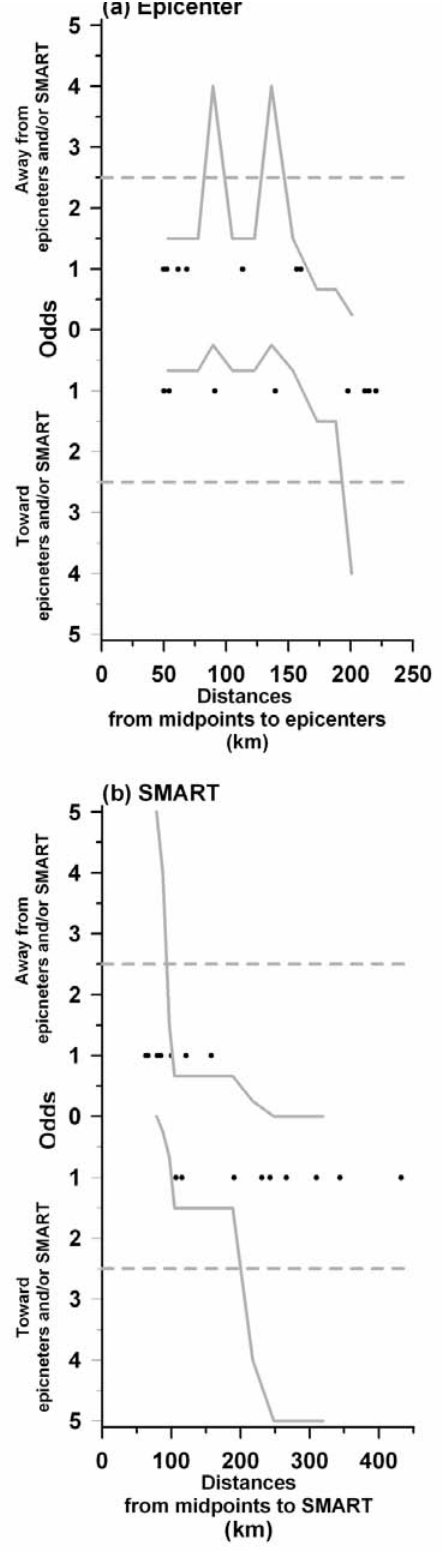
Figure 7. Relationships between the propagation azimuth of SMEWs and the distances from the midpoints to the epicenters (a) and the SMART (b) as well as their odds results. Solid circles plotted on 1 of the upper and lower vertical axes indicate that SMEWs propagate away from and towards the reference points, respectively. The shallow lines are the odds obtained with the window of five continuous earthquakes, for determination of whether the SMEW propagation azimuths are significant or insignificant over the background. Note that the maximum of the odds is 5, due to the window